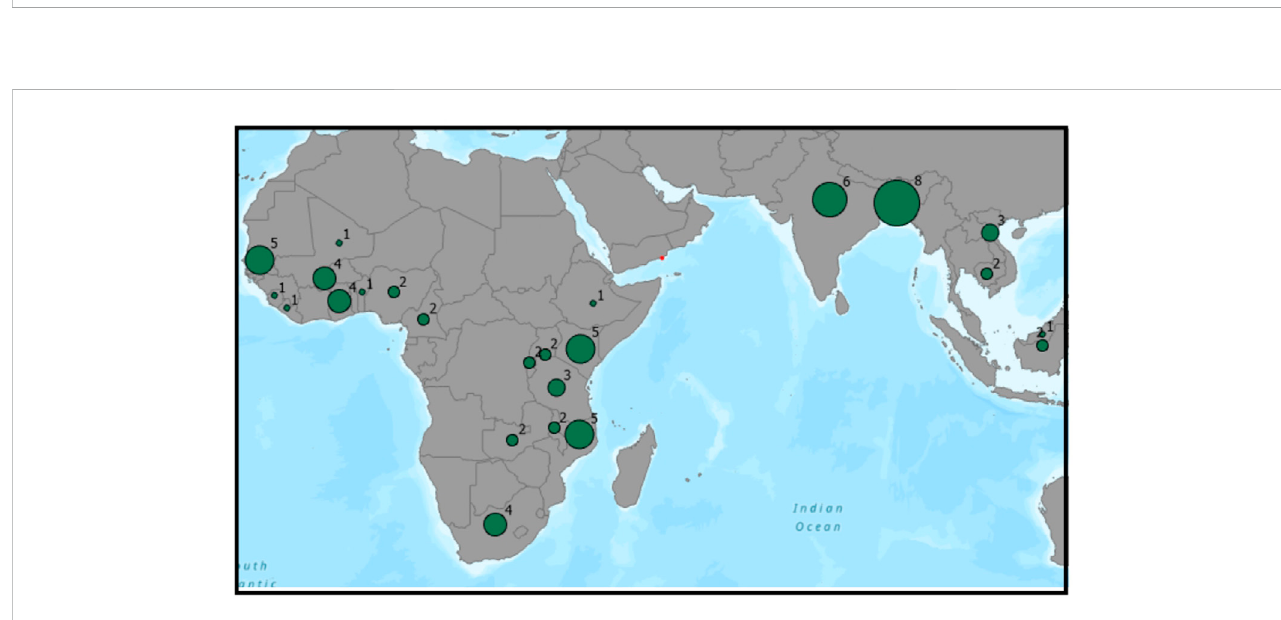
FIGURE 2 Number of studies in countries within Sub-Saharan Africa, South and Southeast Asia selected in the